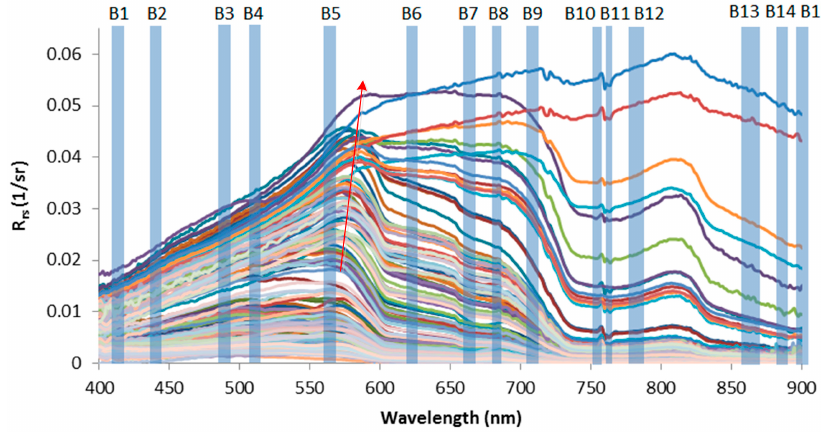
Figure 2. Field measured remote sensing reflectance spectra and the visible–near infrared bands (B 1–15) of the Medium Resolution Imaging Spectrometer (MERIS) sensor. Red arrow covers the peak of spectra.